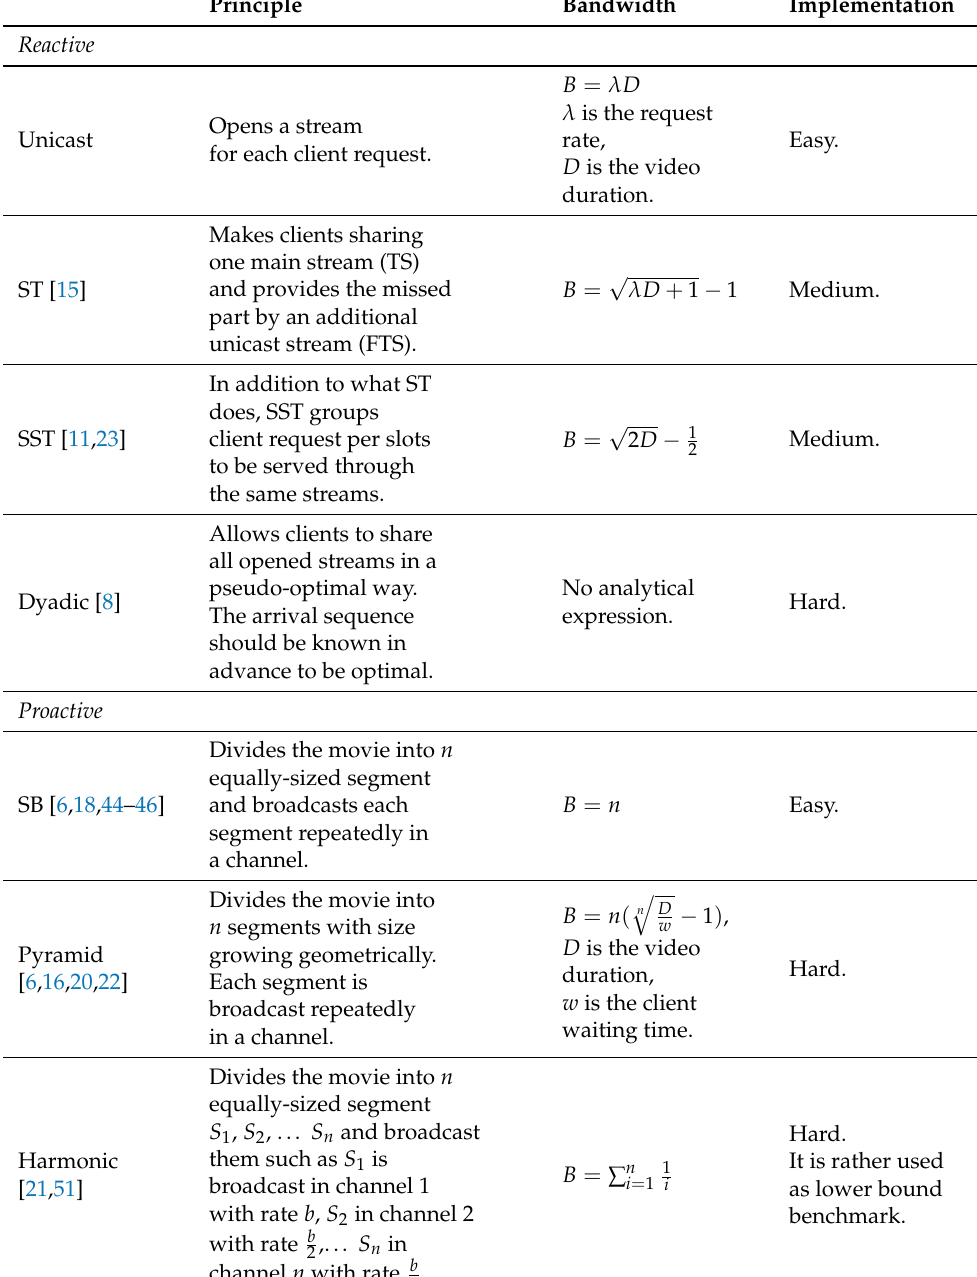
Table 1. Summary of representative works, their principles and